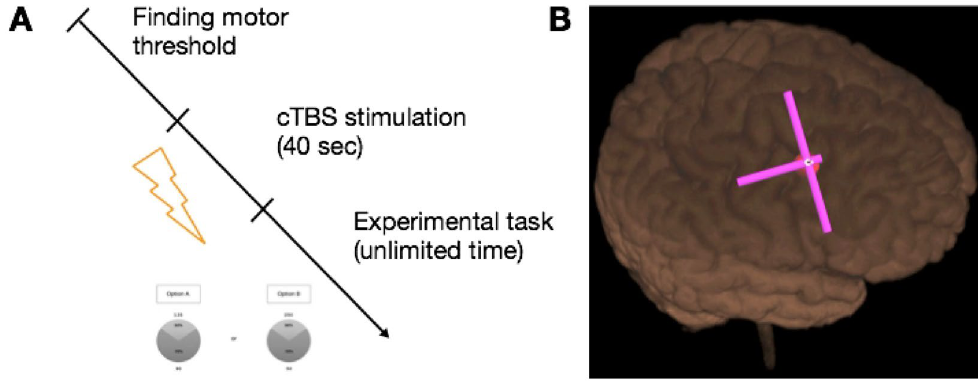
Figure 2. Experimental design. ( A ) experimental timeline. ( B ) example of coil positioning on the head (screenshot of the Localite neuronavigating system